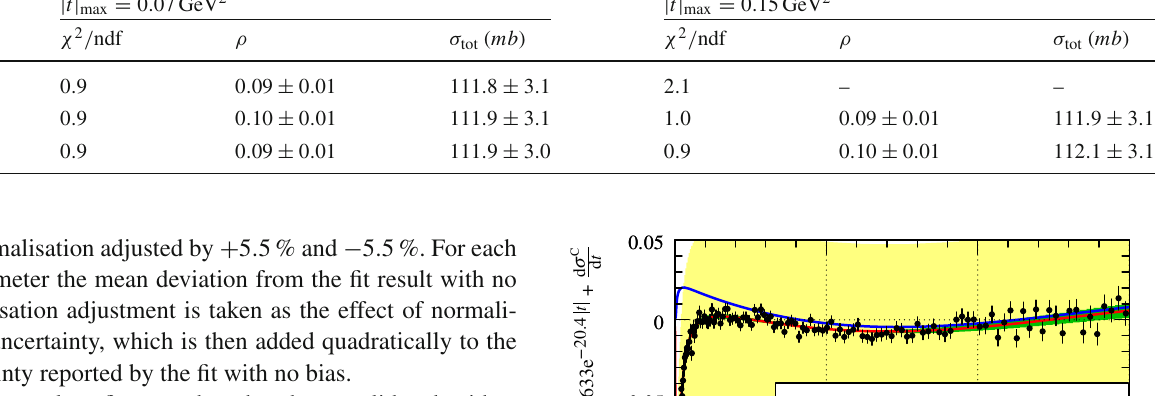
Table 4 Summary of results for various fit configurations (medium binning) N b